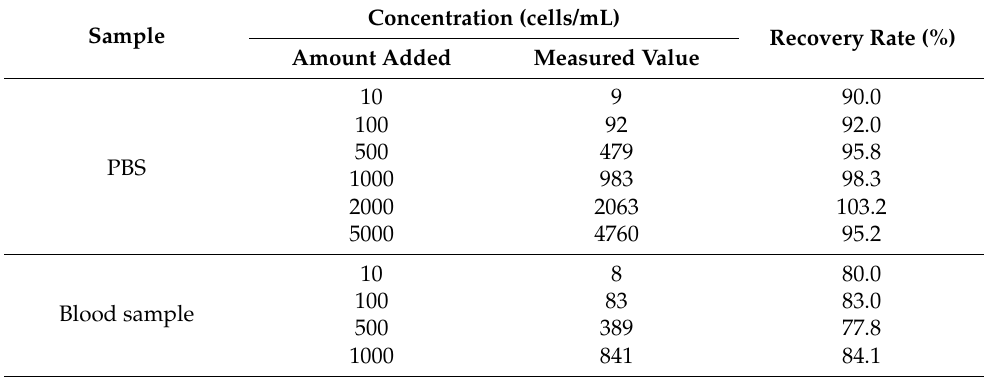
Table 2. Detection of MCF-7 in PBS and human whole-blood samples (n =